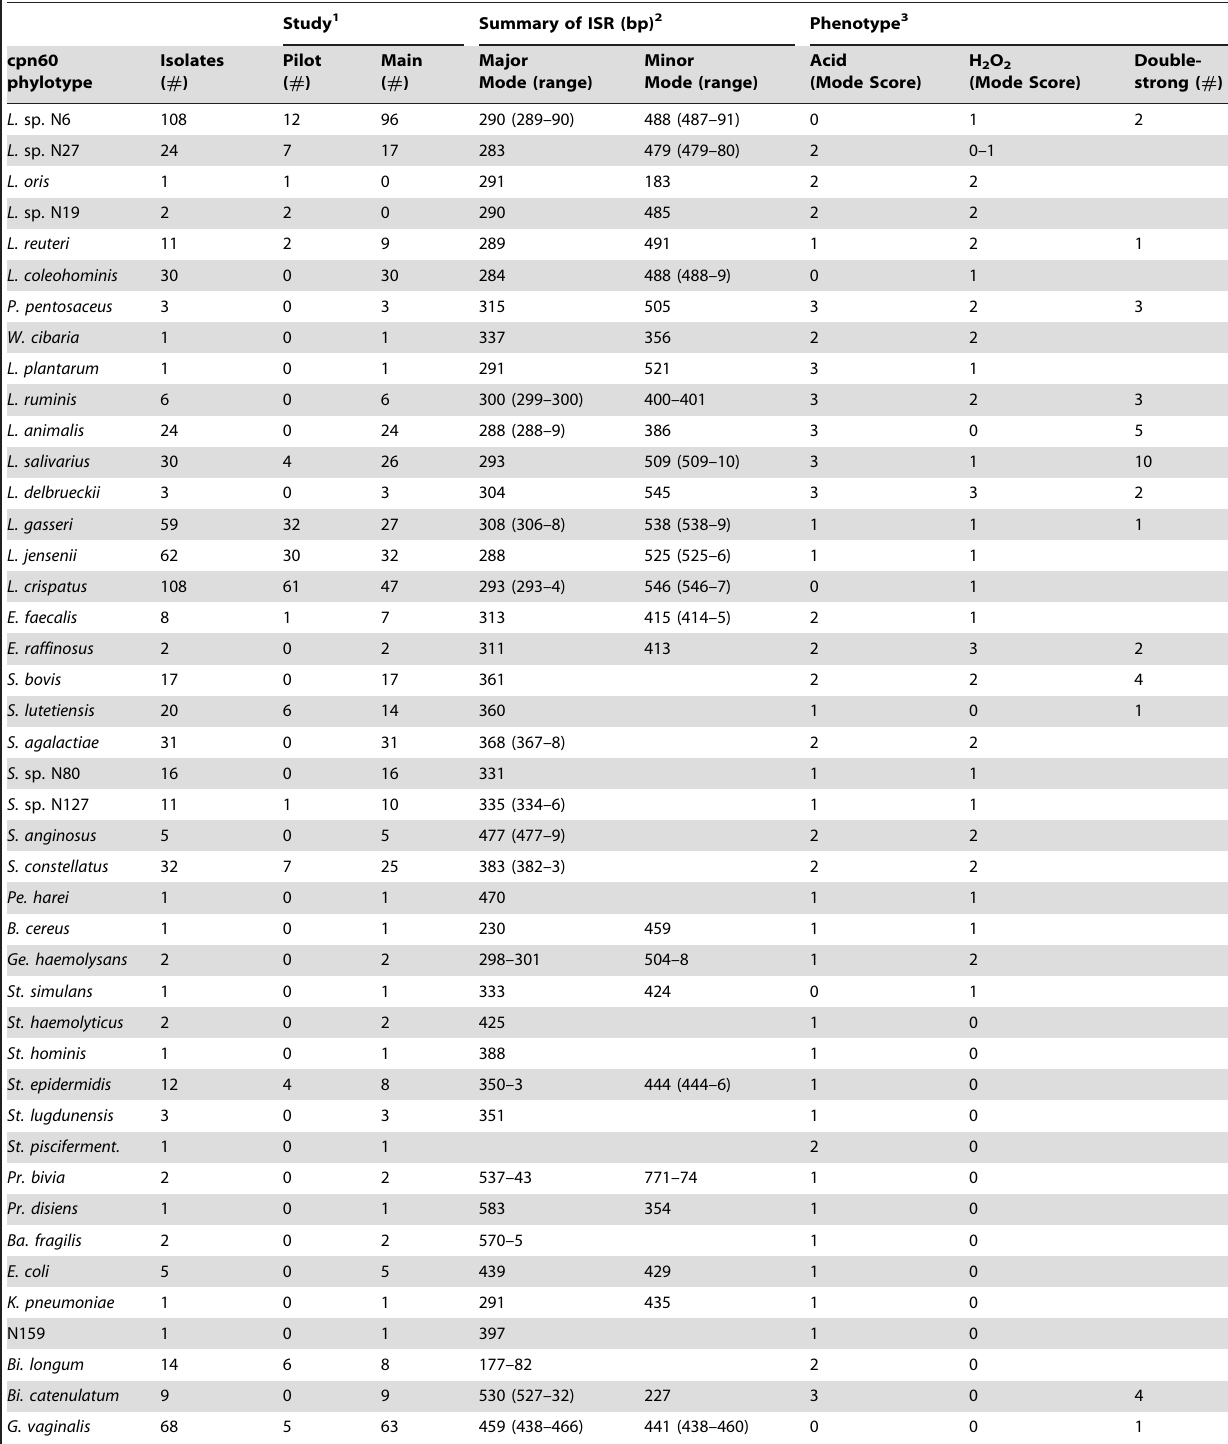
1 Group based on nearest neighbour in cpn 60 reference database, L. Lactobacillus, P. Pediococcus, W. Weissella, E. Enterococcus, S. Streptocococus, Pe. Peptoniphila, B. Bacillus, Ge. Gemella, St. Staphylococcus, Pr. Prevotella, Ba. Bacteroides, E. Escherichia, K. Klebsiella, Bi. Bifidobacterium, G. Gardnerella . 2 Interspacer size in base pairs for major and first minor peak. Value shown is the mode interspacer size with range of observed values shown in brackets. 3 Phenotypic information summarized as mode values of each cpn 60 group in terms of intensity of acid and H 2 O 2 production on 4-point scales (see Methods), and total number of double-strong isolates in each cpn 60 group.